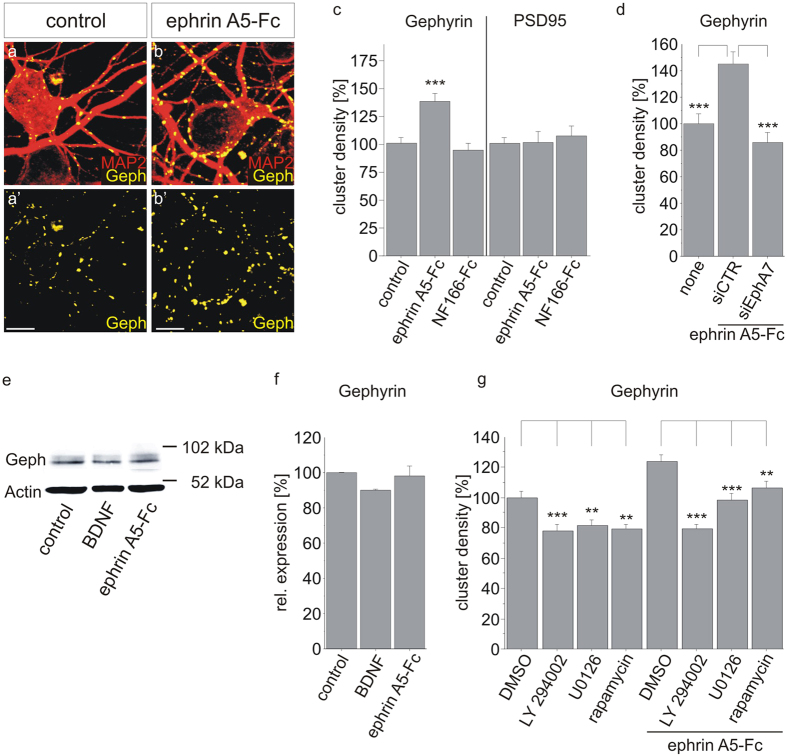
Ephrin A5 stimulation increases gephyrin cluster density via EphA7.(a,b) Hippocampal cultures were treated with preclustered ephrin A5-Fc for 24 hrs. Cells were co-stained for MAP2 (red) and gephyrin (yellow). (a’, b’) The same micrographs as in (a,b), showing gephyrin signals only. All images were rendered using Imaris software. Scale bars, 10 μm. (c) After ephrin A5-Fc treatment, gephyrin and PSD95 cluster densities were quantified on MAP2-positive dendrites. n = 30; ***p < 0.001. (d) Prior to ephrin A5-Fc stimulation, hippocampal neurons were transfected with control siRNA or siRNA specific for EphA7 as well as pEGFP-N1 for the identification of transfected cells. n = 30; ***p < 0.0001. (e,f) Determination of relative gephyrin expression levels after ephrin A5-Fc treatment. Protein lysates of cortical neurons were treated for 30 min with BDNF or preclustered ephrin A5-Fc, submitted to SDS-PAGE and subsequent Western Blotting. Gephyrin expression was quantified in comparison to the actin signal as a loading control. n = 3. (g) Untreated or ephrin A5-Fc-stimulated hippocampal neurons were further treated with inhibitors for PI3K (Ly294002), MEK (U0126), or mTOR (rapamycin) for 24 hrs. n = 135; **p < 0.01; ***p < 0.0001; ANOVA, Fisher-PLSD; error bars, S.E.M.